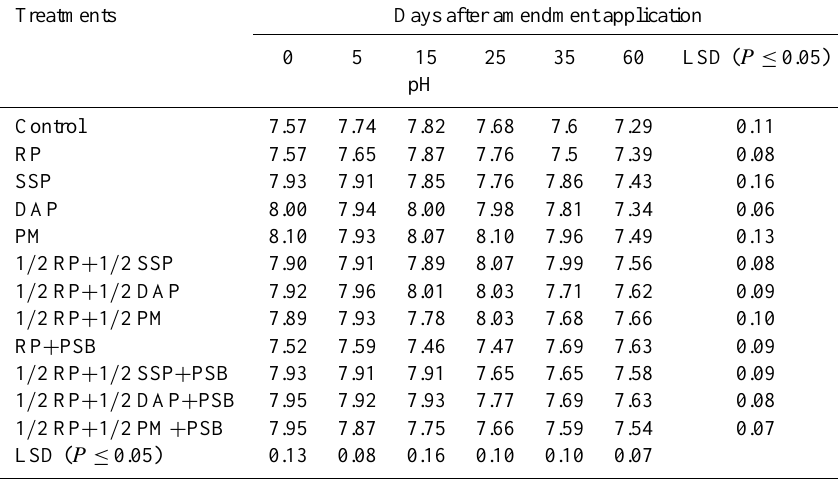
Table 3. Changes in pH of the soil supplemented with soluble P fertilizers and insoluble rock phosphate (RP) along with phosphate- solubilizing bacteria (PSB) and poultry manure (PM) and incubated under controlled laboratory conditions at 25 ◦ C over a 60-day period. Treatments